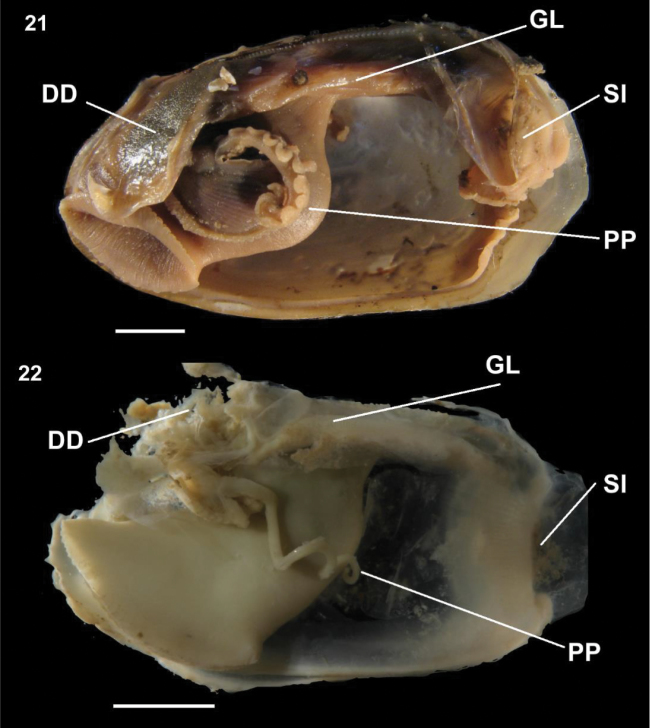
21Malletiaalata (EMU7054) Gulf of California, Mexico, lateral view of anatomy 22Malletiatumaquensis sp. n. Lateral view of anatomy. Scale bars: 0.5 mm. Abbreviations: DD Digestive diverticula, FT Foot, GL Gill, SI Siphon, PP Palp proboscis.